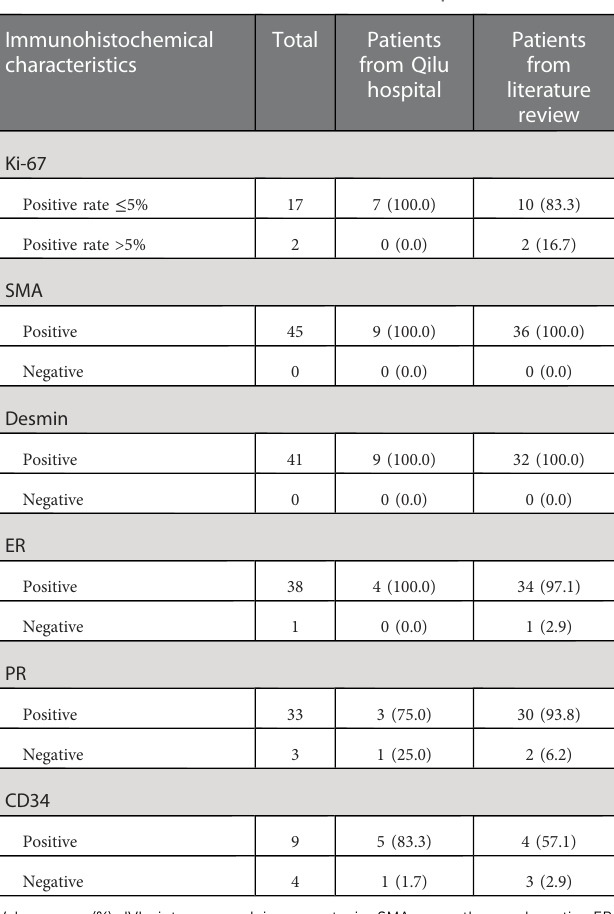
TABLE 2 Immunohistochemical characteristics of IVL